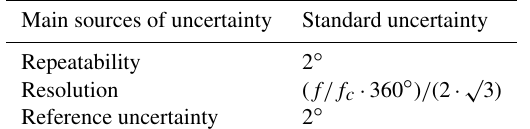
Table 3. Uncertainty budget for the phase evaluation. fc is the sam- pling rate, f is the oscillation frequency.